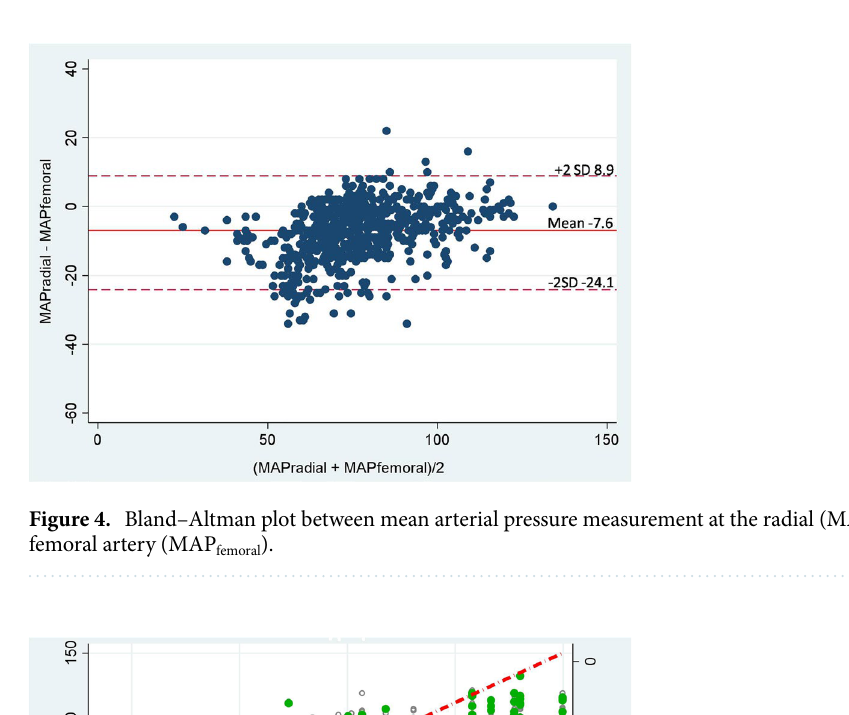
Figure 3. The mean arterial pressure from the radial (MAP radial ) and femoral artery (MAP femoral ).